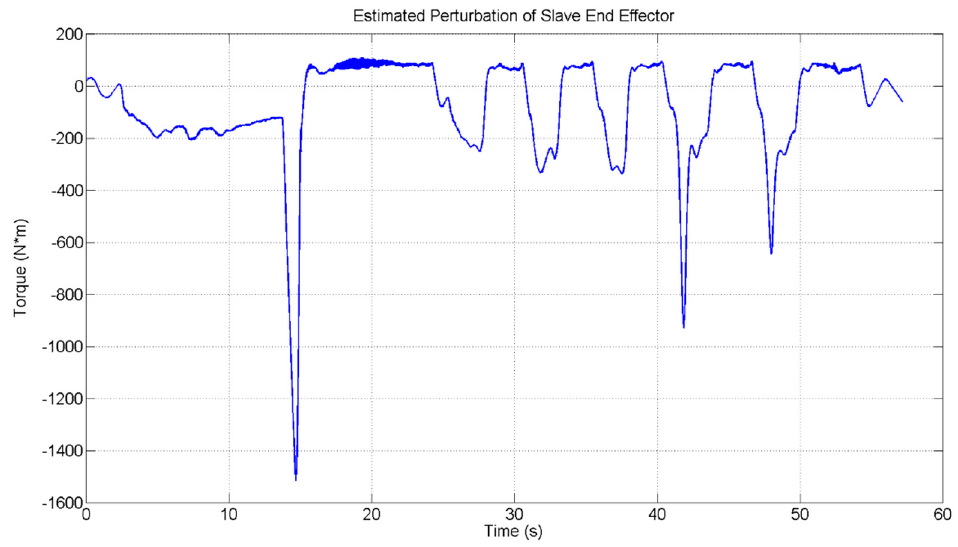
Figure 14. Estimated perturbation of slave for end effector.